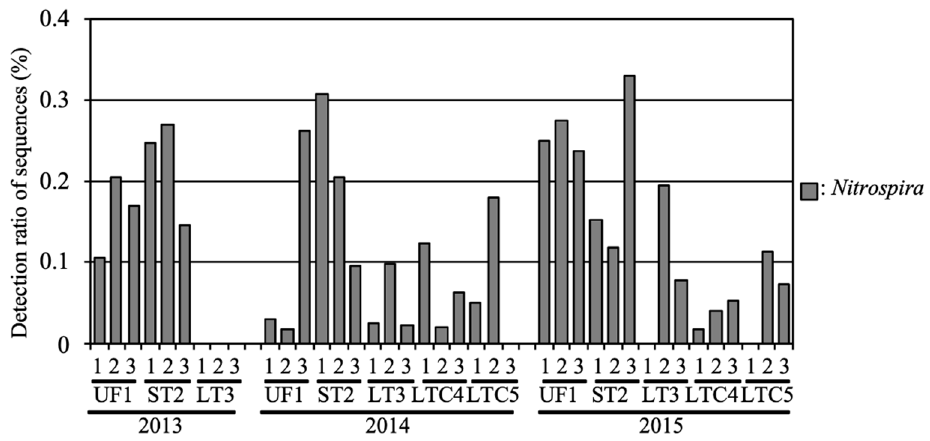
Figure 6. Relative abundance of the nitrite-oxidizing bacteria (NOB) in the soil samples.